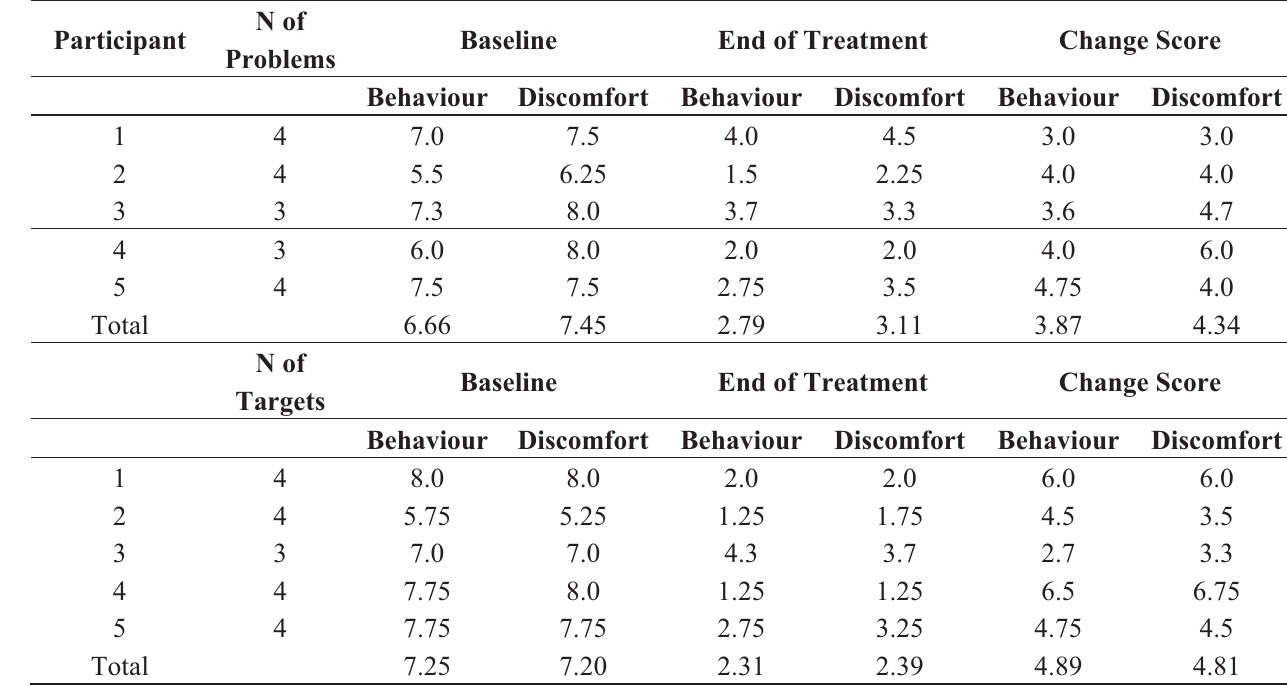
Table 4. Mean problem and target baseline, end of treatment and change scores for each